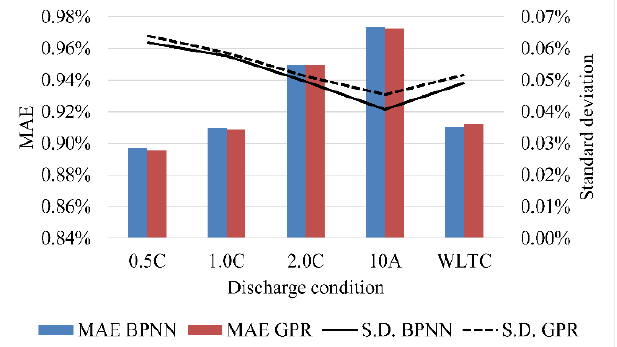
Figure 13. Comparison of MAE and standard deviation between BPNN and GPR.